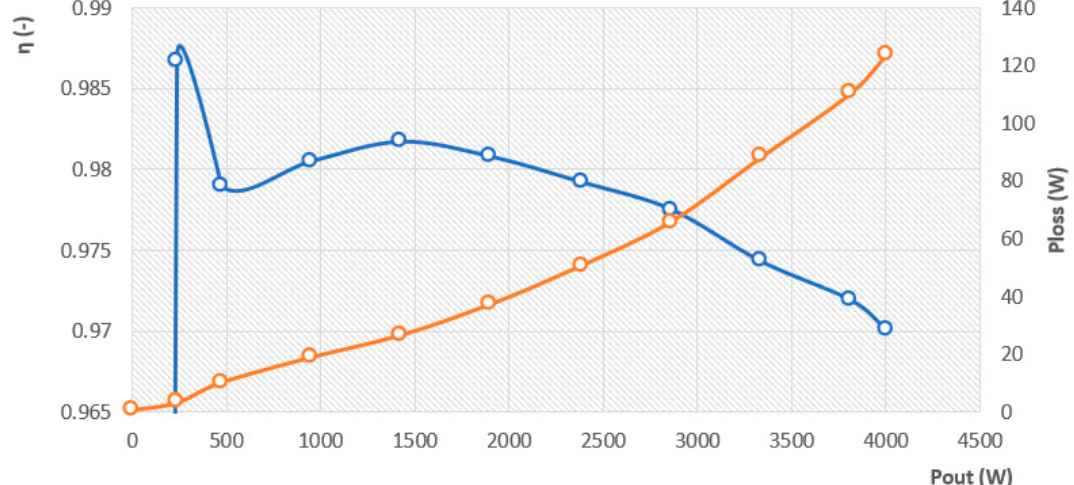
Figure 6. Efficiency characteristic of analyzed non-optimized PFC converter and power loss dependency on the output power of converter.